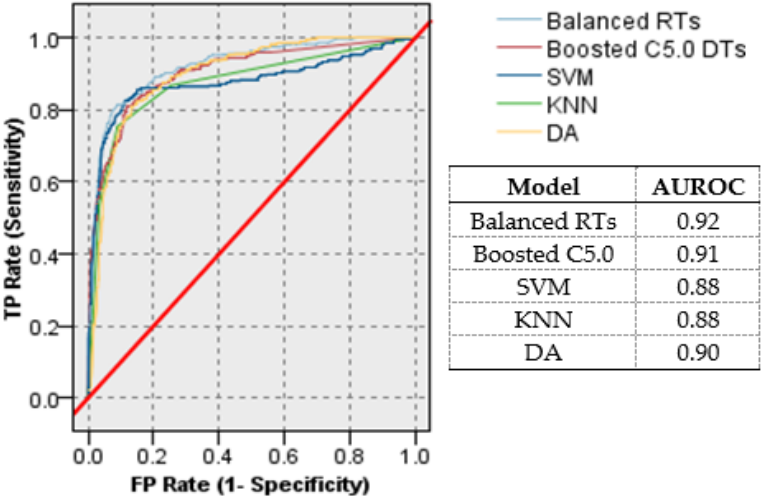
Figure 4. ROC curves and the area under the ROC curve (AUROC) values of the RB class for the test data. The higher the curve to the left, the higher the model's predictive power than the others.